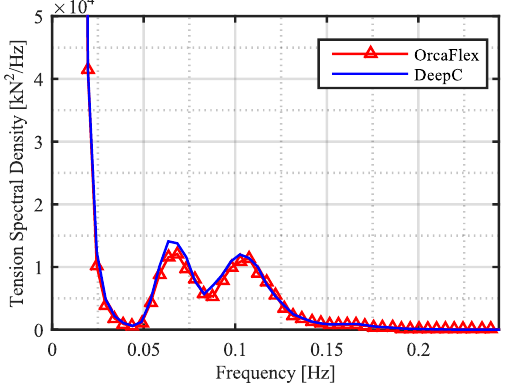
Figure 6. Tension spectral density in the mooring line on the seaward side of the WEC.